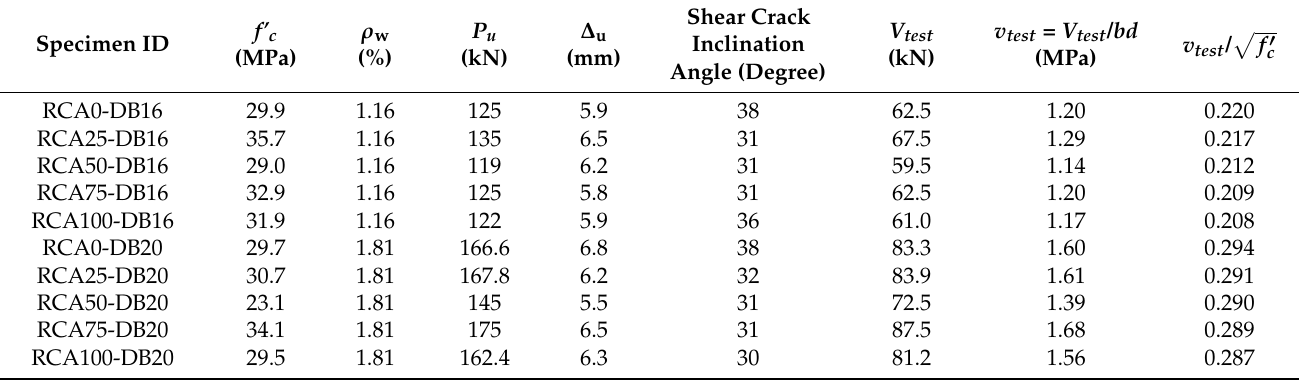
Table 4. Summary of the test